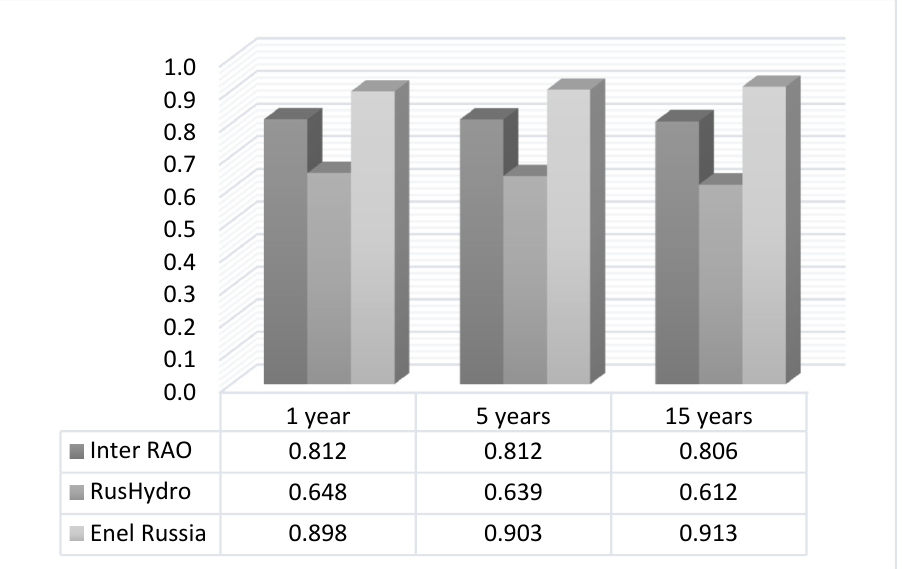
Figure 8. Interdependence of multinational corporations’ energy flexibility and their development level. Source: generated by the authors. The relationship is also confirmed by the determination coefficient R 2 = 0.63. It indicates a sufficient level of correlation between the studied indicators, as well as the adequacy of the generated regression equation. Based on the resulting regression equation, the authors modeled the development indicators of the studied multinational corporations, taking into account the increase in energy production from renewable sources (Figure 9).